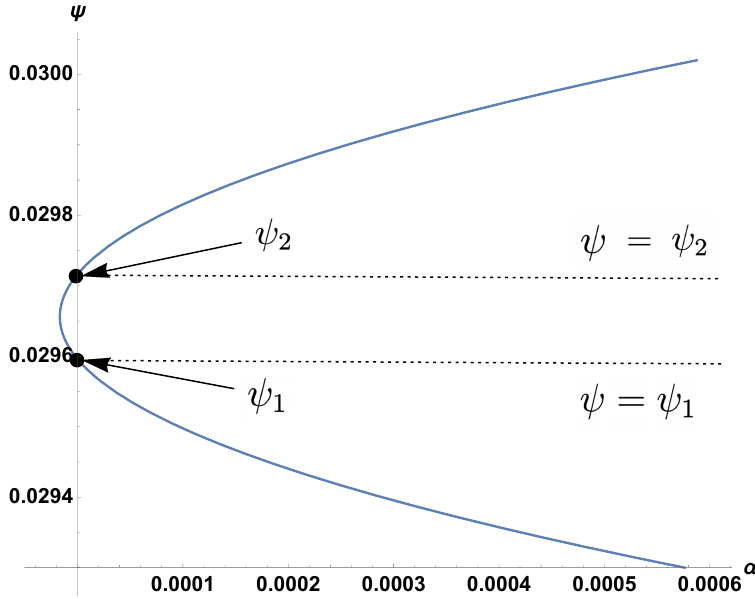
Figure 1. Hyperbola crossing the ψ -axis with horizontal lines ψ = ψ 1 and ψ = ψ 2 using “sample value” parameters from the “revised” column of Table 1. Note the relatively small parameter ranges of α and ψ .